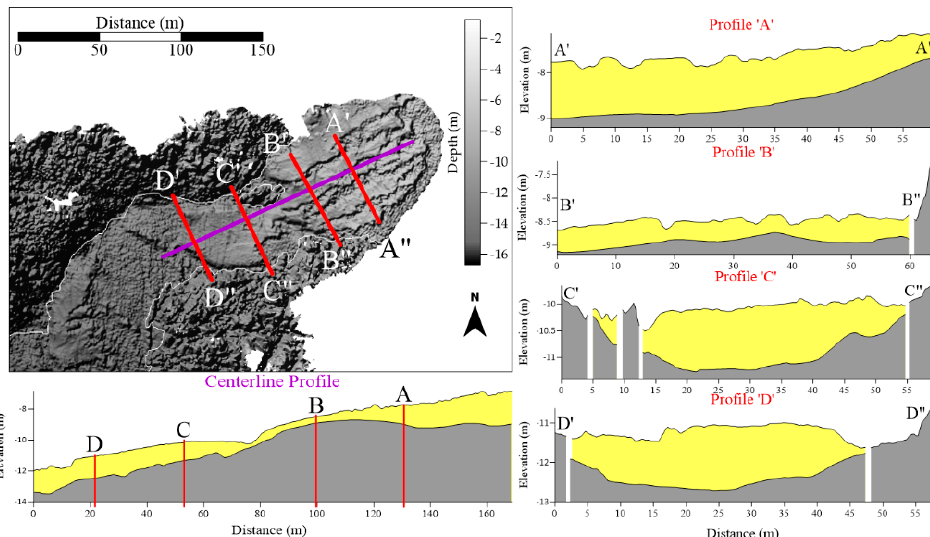
Figure 6. Acoustic slices/profiles of the survey region. The bedrock underneath the sandy substrate being a kriging interpolation of the sub-bottom acoustic reflector data.